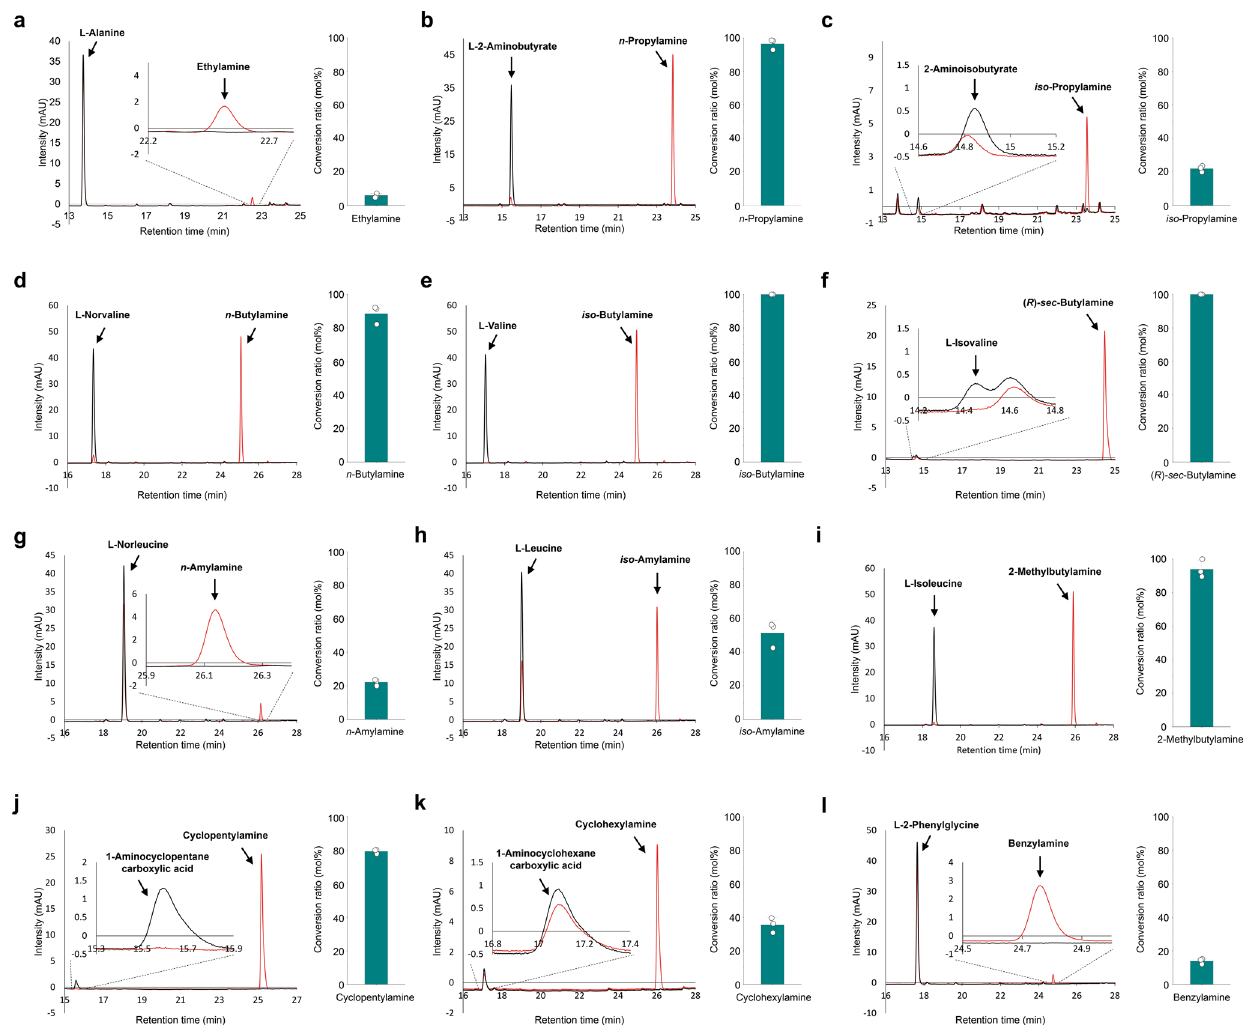
Fig. 3 In vitro enzyme assay of VlmD producing 12 SCPAs. High-performance liquid chromatography (HPLC) chromatograms of in vitro enzyme assays conducted using VlmD, which converted: ( a ) L -alanine to ethylamine; ( b ) L -2-aminobutyrate to n -propylamine; ( c ) 2-aminoisobutyrate to iso -propylamine; ( d ) L -norvaline to n -butylamine; ( e ) L -valine to iso -butylamine; ( f ) L -isovaline to ( R )- sec -butylamine; ( g ) L -norleucine to n -amylamine; ( h ) L -leucine to iso - amylamine; ( i ) L -isoleucine to 2-methylbutylamine; ( j ) 1-aminocyclopetanecarboxylic acid to cyclopentylamine; ( k ) 1-aminocyclohexanecarboxylic acid to cyclohexylamine; and ( l ) L -2-phenylglycine to benzylamine. Black and red lines in the left graph for each SCPA indicate chromatograms from in vitro enzyme assays without VlmD (control) and with VlmD, respectively. Green bar graphs indicate percentage (%) of amino acid precursors converted to their corresponding SCPAs by the VlmD after two hours of enzymatic reaction at 37 °C. Experiments were conducted in triplicates. Data are presented as mean values ± s.d. Source data are provided as a Source Data fi